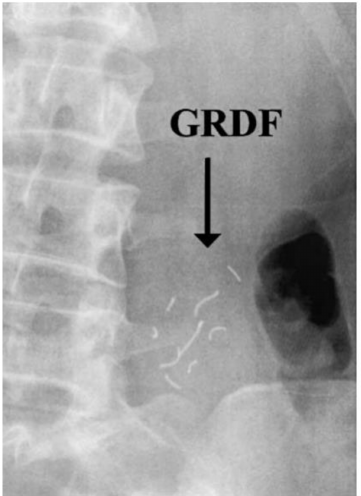
Figure 16. X-ray image of the unfolding system proposed by Klausner et al. and reprinted from Reference [131] with permission from Springer Nature.